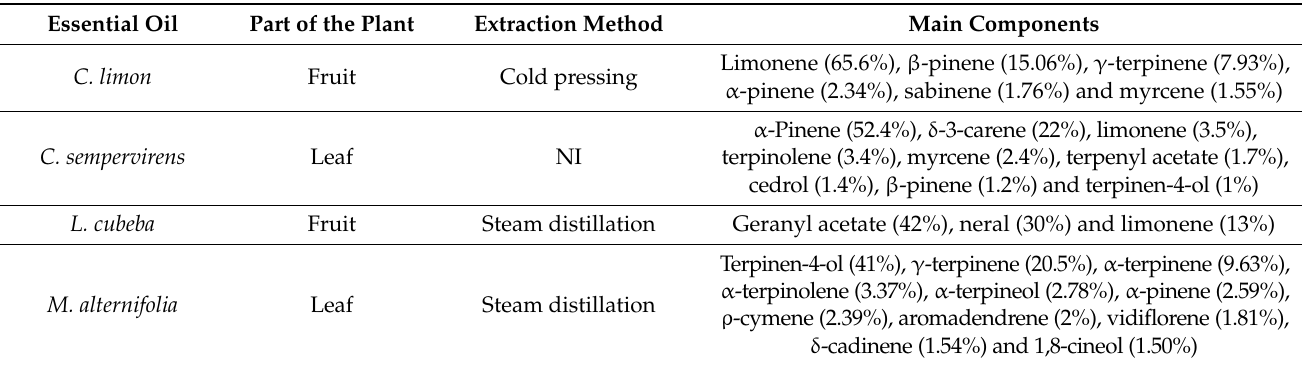
Table 1. Main components of essential oils from Citrus limon , Cupressus sempervirens , Litsea cubeba and Melaleuca alternifolia , according to the supplier